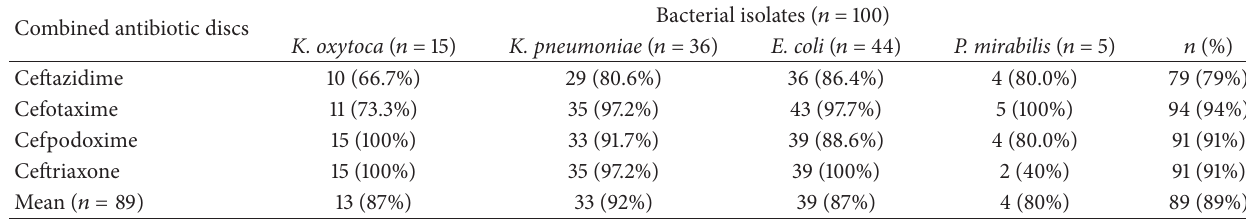
Table 2: Prevalence of phenotypic ESBL-producing isolates by combined disc diffusion test. Combined antibiotic